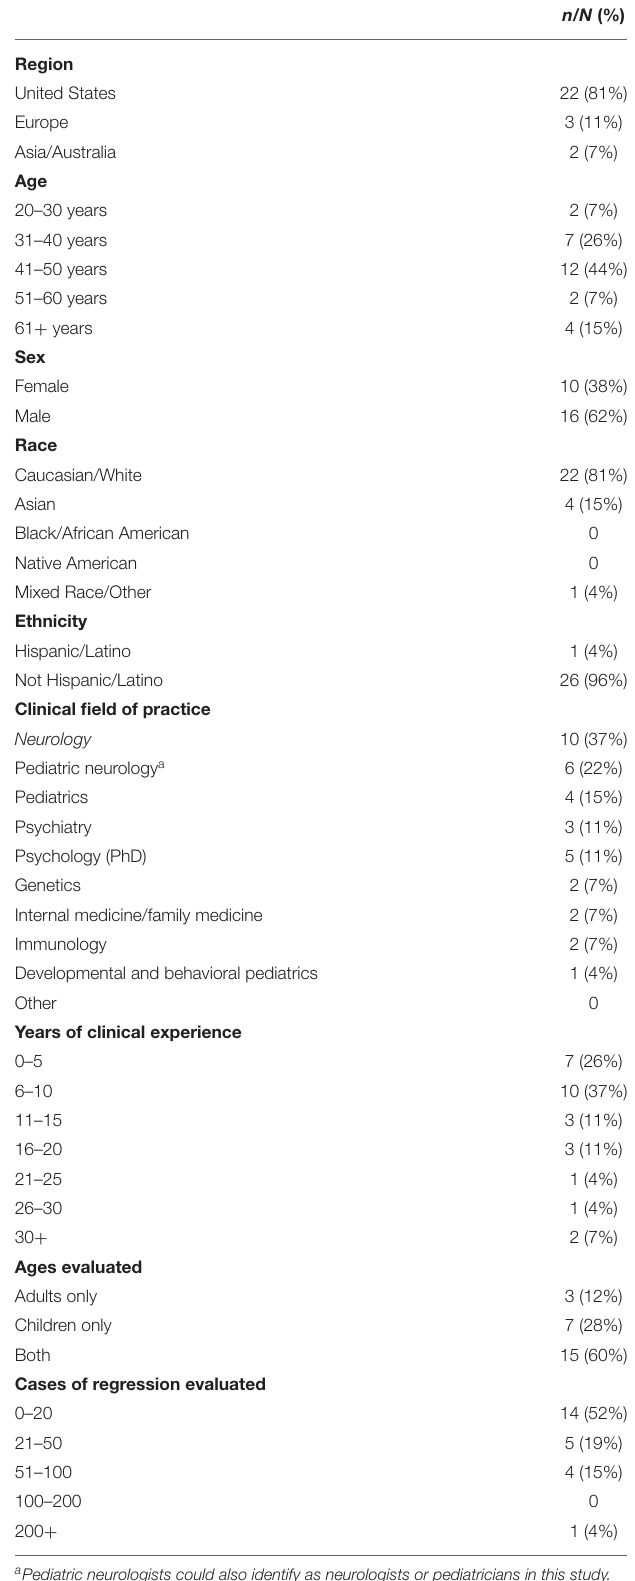
TABLE 1 | Demographics of expert panel ( n =